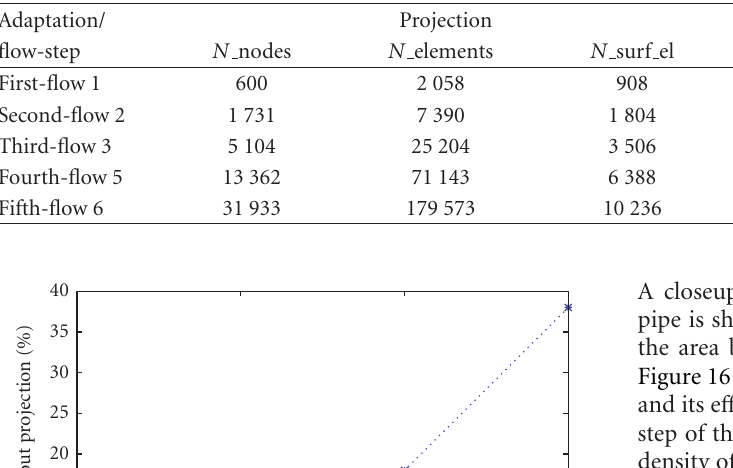
Table 2: Grid sizes for adapted channel bump calculations and relative flow solver step—with and without projection algorithm.